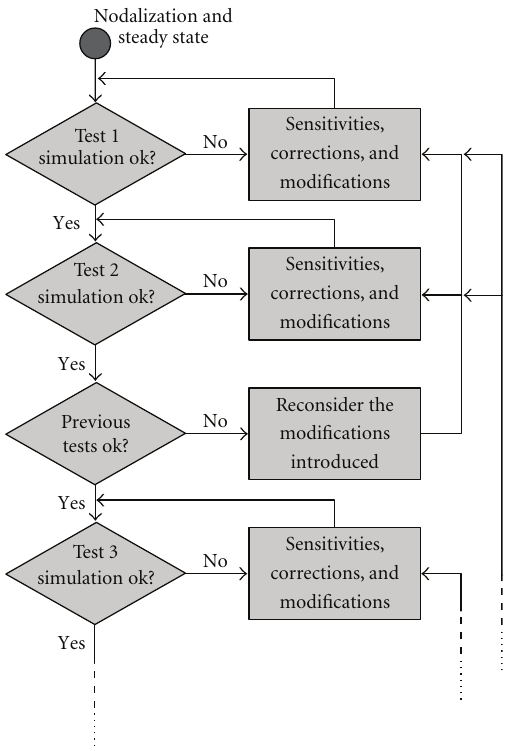
Figure 7: Flowchart for the model